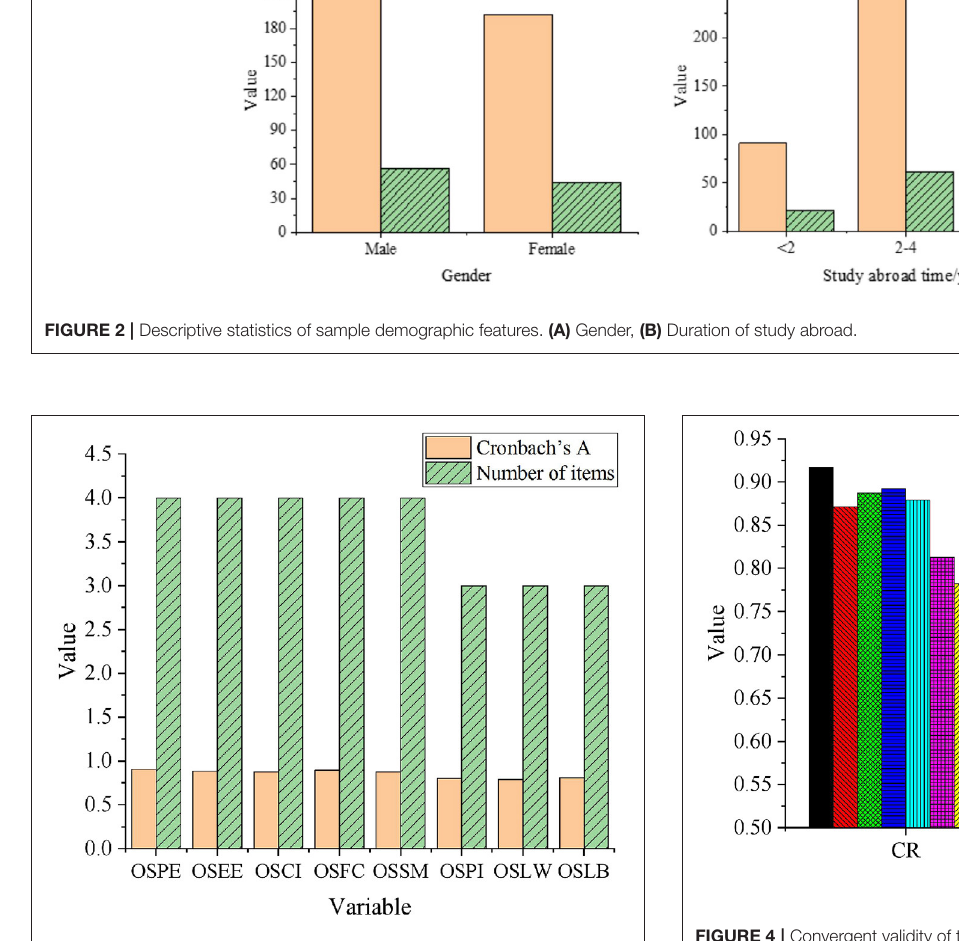
FIGURE 3 | Reliability of each dimension.